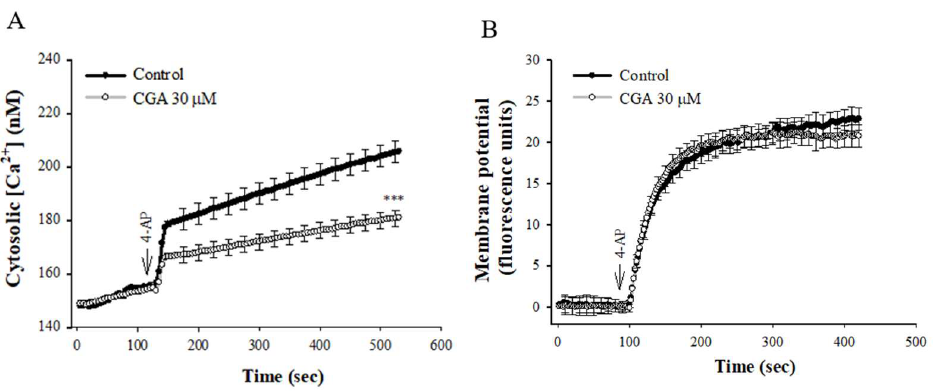
Figure 2. Effect of CGA on [Ca 2+ ] C ( A ) and the synaptosomal membrane potential ( B ). CGA was added 10 min before the addition of 4-AP. Data are presented as mean ± SEM. ( n = 5 per group). ***, p < 0.001 vs. control group.